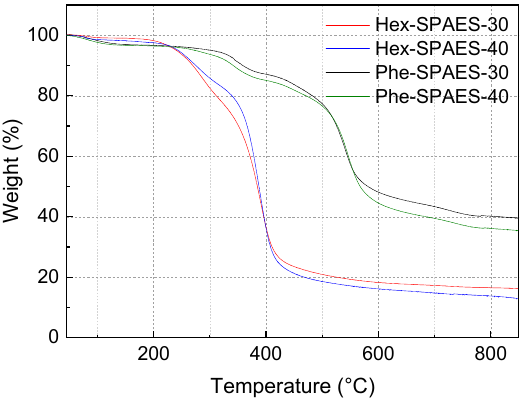
Figure 2. TGA thermograms of the synthetic polymer membranes.